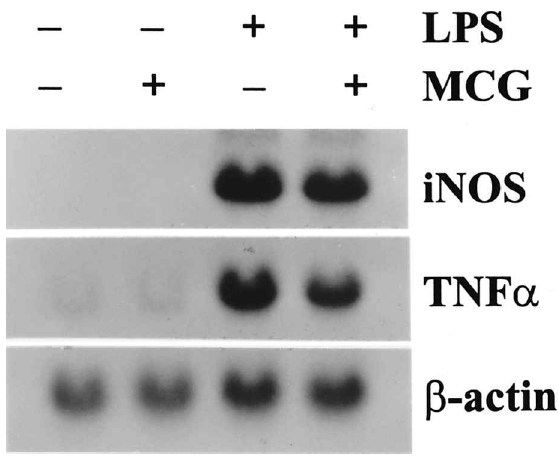
FIG. 9. Effect of MCG exposure on LPS-induced iNOS and TNF- a mRNA expression in J774 cells. J774 cells were pre- treated with MCG at a J774 cell to mast cell ratio of 5 to 1 for 3h and were then stimulated with LPS for 6h. Total RNA extracted at the end of the incubation were electrophoresed on 1% agarose gel, transferred to a Nytran nylon membrane, and sequentially hybridized with specific 32 P-labelled cDNA